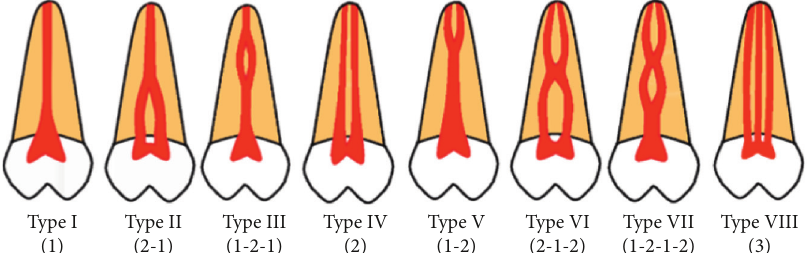
Figure 3: Illustrative image of the morphological classification of root canals according to Vertucci